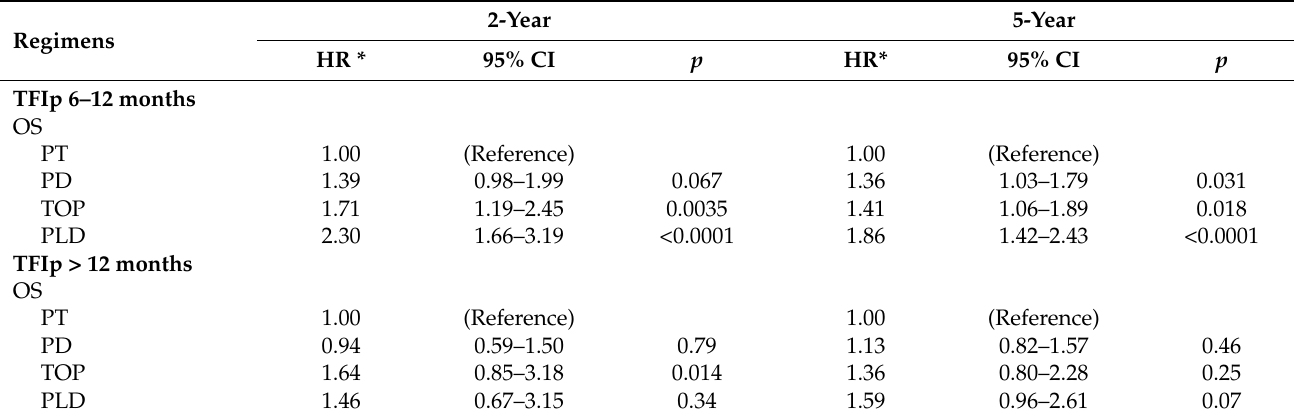
Table 3. Multivariate Cox regression model of overall survival (OS) for 504 and 534 recurrent advanced EOC patients with TFIp between 6 and 12 months and TFIp >12 months.